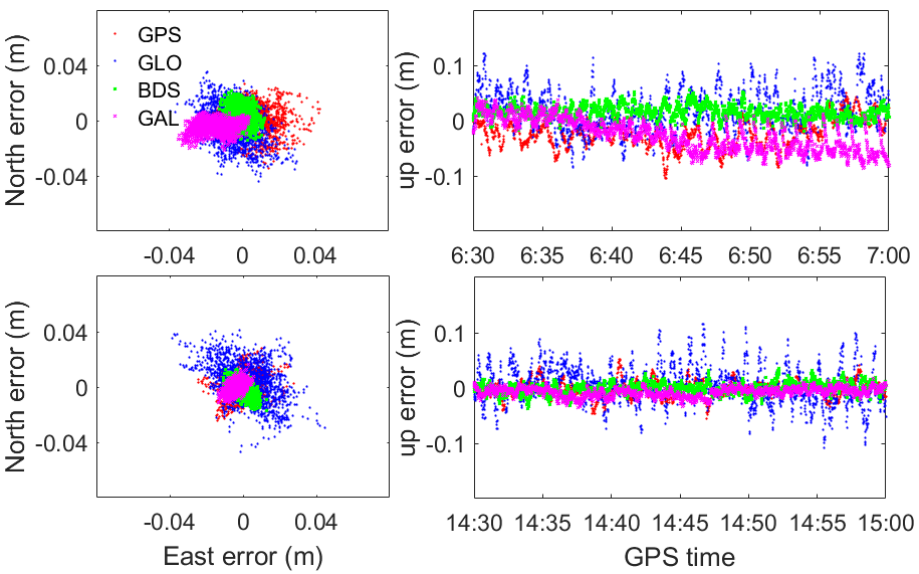
Figure 10. ARTK position errors of Sessions A2 ( top ) and A3 ( bottom ) for Bs.2. Table 7. ARTK position RMS (mm) of Sessions A1-3, B1-3 from Bs.2 using broadcast and c2t ephemeris. Session